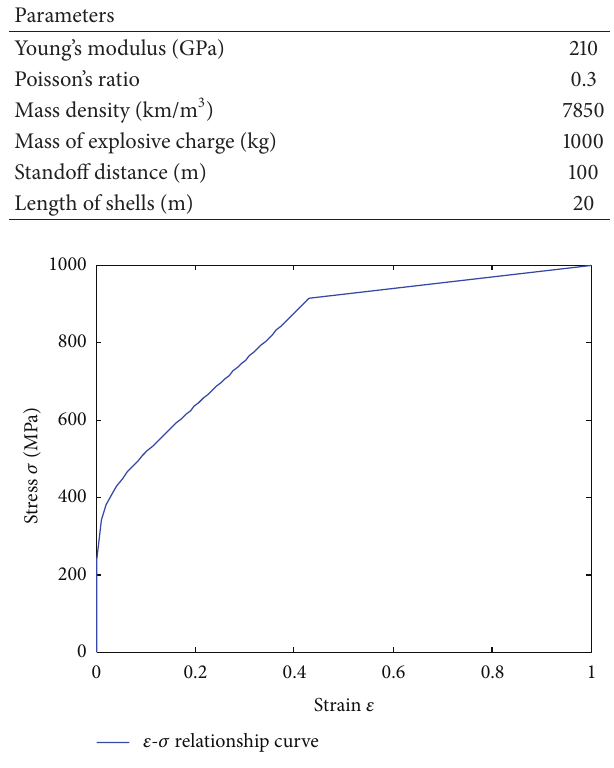
Figure 2: Strain-stress curve of stainless steel.